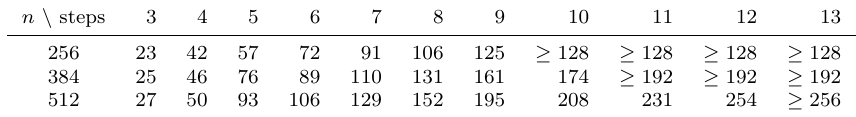
Table 7: The quantity − log for different block sizes. For 1 and 2 steps, we always have that − log 17